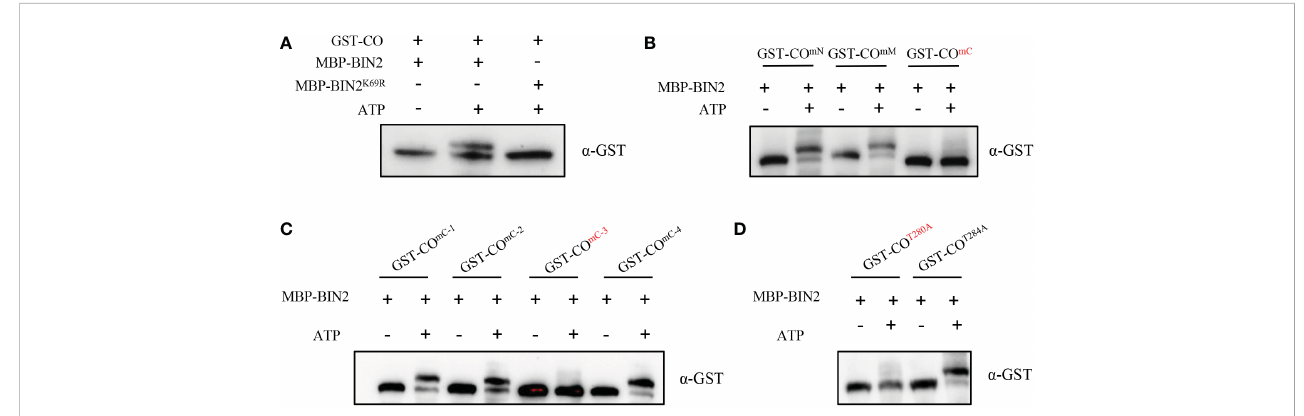
FIGURE 3 BIN2 phosphorylates CO. (A) Phosphorylation assays showing the BIN2-mediated phosphorylation of CO in vitro . Proteins were detected by immunoblotting with anti-GST antibody. (B, C) Phosphorylation assays showing the BIN2-mediated phosphorylation of CO with different mutant forms in vitro . Proteins were detected by immunoblotting with anti-GST antibody. (D) Phosphorylation assays showing the BIN2-mediated phosphorylation of CO T280A and CO T284A . Proteins were detected by immunoblotting with anti-GST